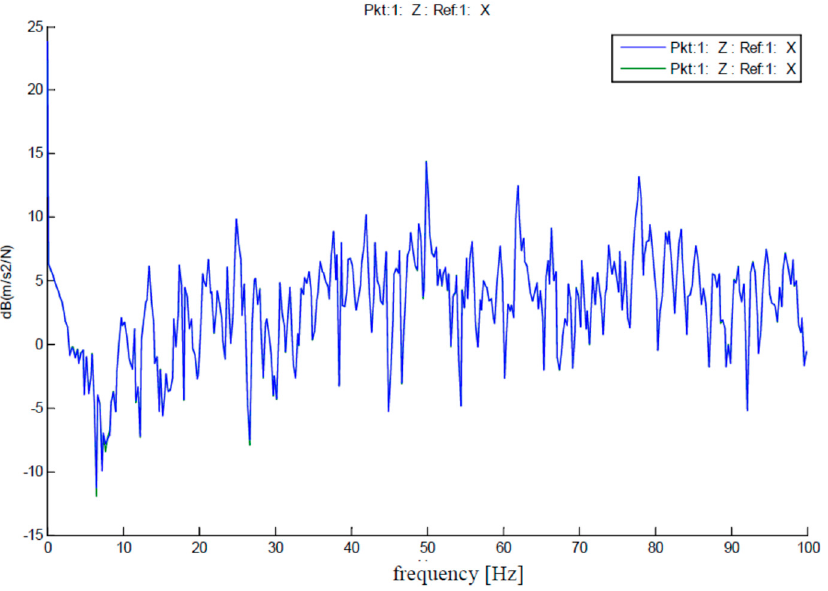
Figure 11. Frequency response function estimated with the application of the discussed methods of averaging.